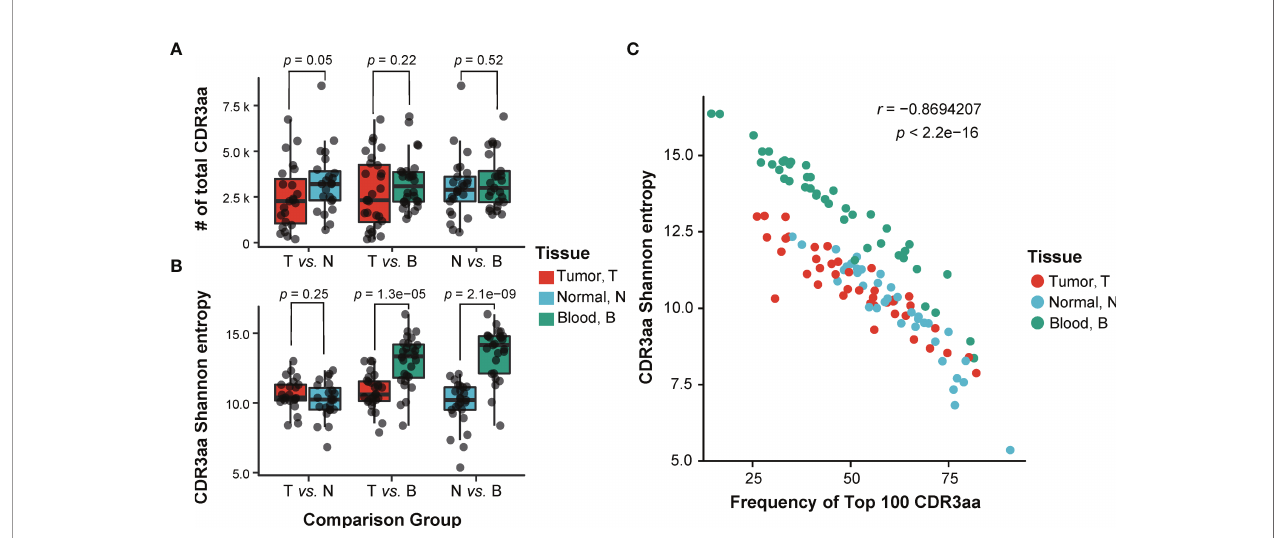
FIGURE 2 | Comparison of TCR b CDR3 characteristic among three different sites. (A, B) Comparison of the number (A) and the diversity (B) of TCR b CDR3 amino acid sequences among three tissues. T, tumor; N, adjacent non-tumor tissues; B, peripheral blood. p -Values shown are according to paired t-test. (C) The correlation of the diversity of TCR b CDR3 and abundance of top 100 CDR3. p -Values shown are according to t-test. TCR, T-cell